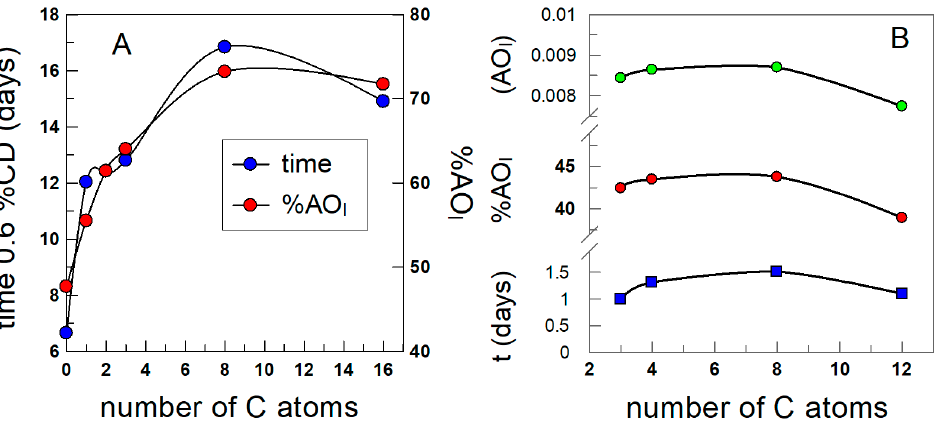
Figure 6. Direct correlation between the antioxidant efficiency (time to reach a selected percentage of conjugated dienes) and the percentage of antioxidant in the interfacial region for ( A ) caffeic acid and its derivatives and ( B ) gallic acid and its derivatives. ( A ) Reproduced from reference J Sci Food Agric (2016); ( B ) Reproduced from reference Food & Function, 2018, 9, 4429–4442.